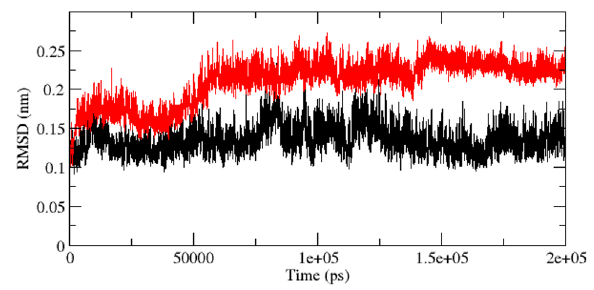
Figure 4. Backbone RMSDs are shown as a function of time for native and mutant Aurora-A protein structures at 300 K. Native is shown in black and mutant in red.